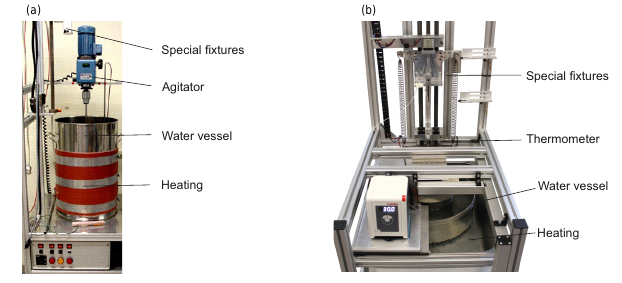
Figure 4. Test equipment for flowing water ( a JUMO GmbH & Co. KG Fulda company, b TU Ilmenau).